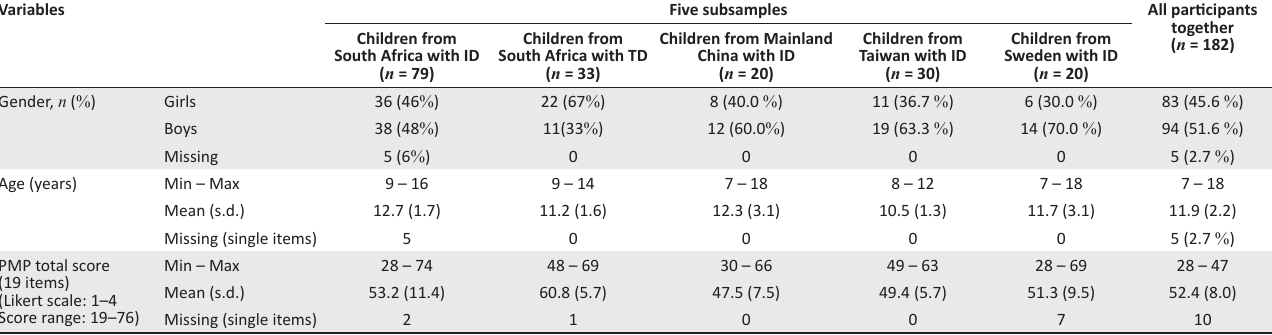
TABLE 1: Descriptive data regarding gender, age and Picture My Participation total scores for the five subsamples and for all participants together.